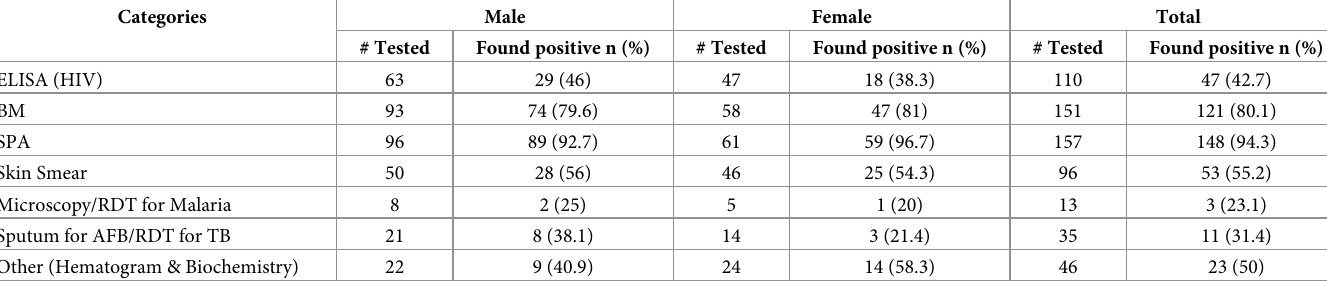
Table 3. Distribution of other diagnostic tests for co-infection, PKDL, relapse and